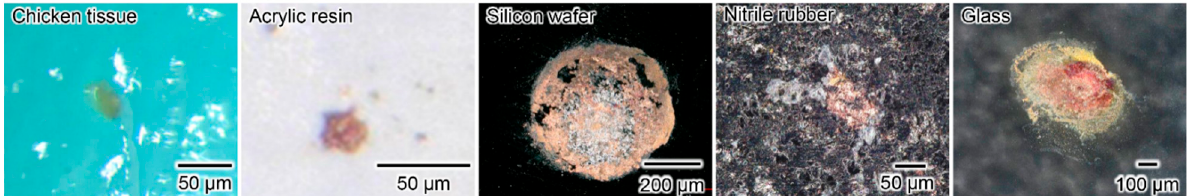
Figure 5. Results of the deposition probability and diameter with varying off time. The plots are color coded according to the bubble generation mode in Figure 4. The voltage was 700 V.